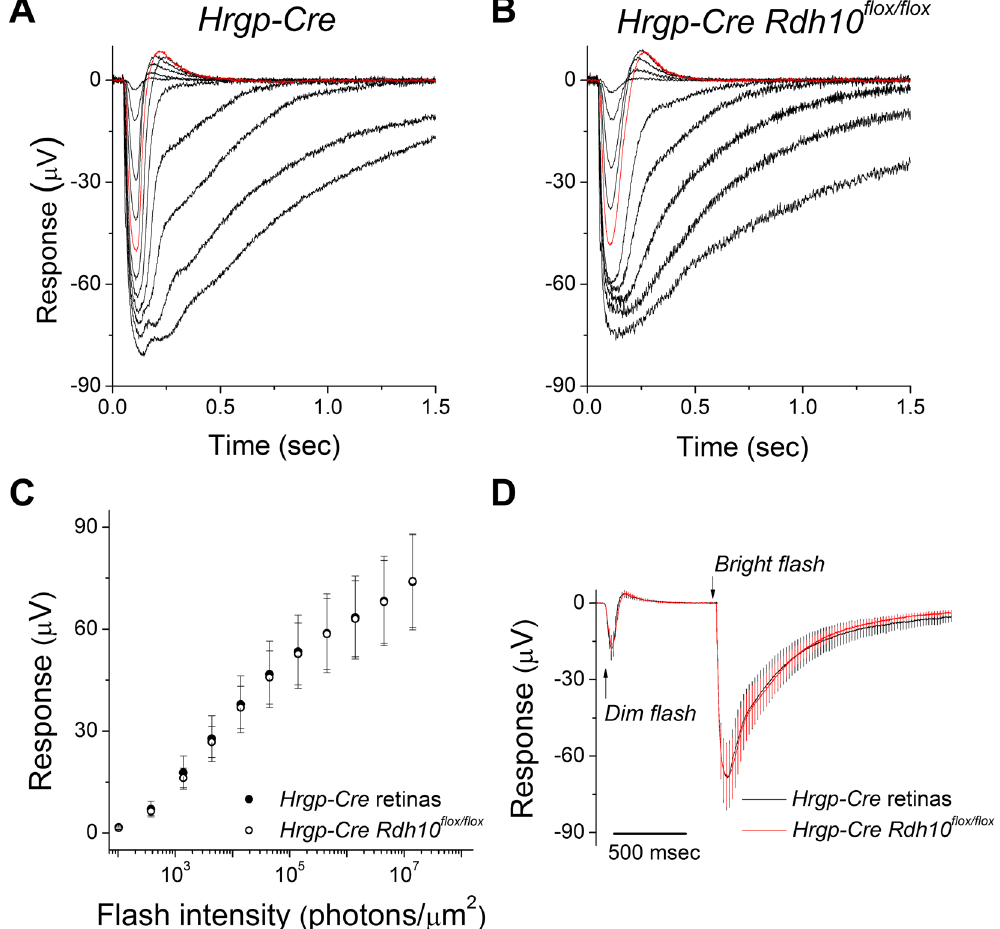
Figure 3. Deletion of RDH10 in cone cells does not affect cone responses. Representative transretinal cone responses from ( A ) Hrgp-Cre control retinas, and ( B ) Hrgp-Cre Rdh10 flox/flox retinas. Red traces: responses to a 1.4 × 10 4 photons/ μ m 2 test flash. ( C ) Ensemble-averaged intensity-response curves of Hrgp-Cre control cones (n = 12, filled symbols) and Hrgp-Cre Rdh10 flox/flox cones (n = 12, open symbols). ( D ) Ensemble-averaged dim flash responses (flash intensity: 1.4 × 10 3 photons/ μ m 2 ) and bright flash responses (flash intensity: 4.5 × 10 6 photons/ μ m 2 ) of Hrgp-Cre control cones (n = 12, black trace) and Hrgp-Cre Rdh10 flox/flox cones (n = 12, red trace). All mice were in Gnat1 − / − background to facilitate cone